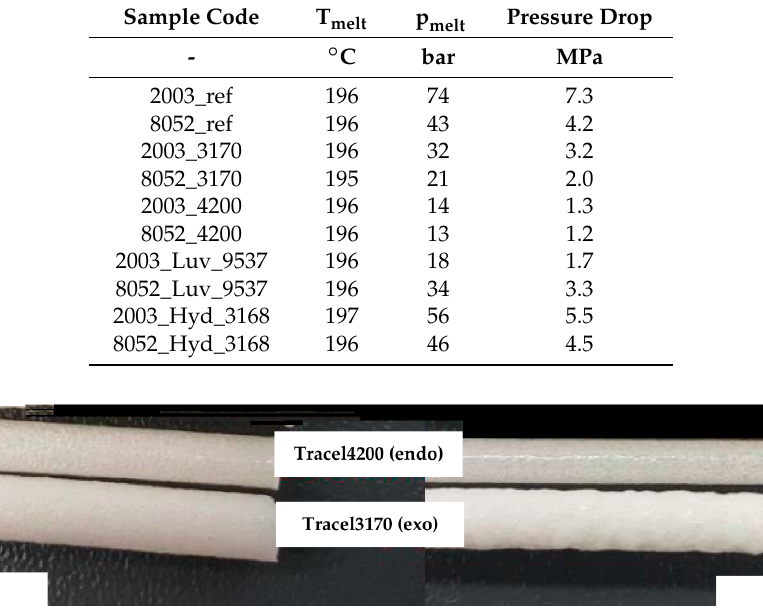
Table 6. The designation of the samples and their recipes. Table 7. Manufacturing parameters.